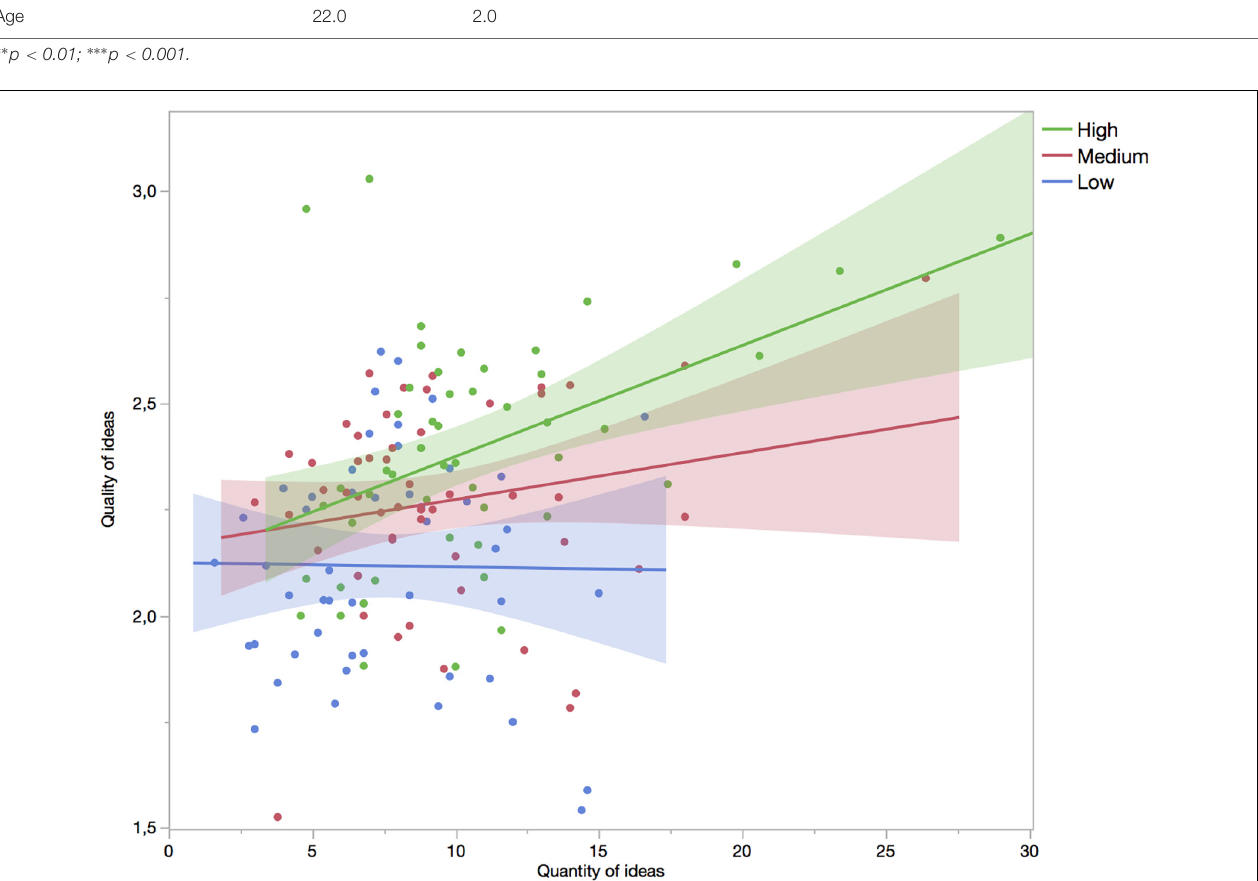
FIGURE 1 | The correlation between the quantity of ideas produced and the rated quality of each idea, which for visualization purposes is calculated separately for each of three levels of openness to experience (high, medium, and low). The color bands each represent the 95% confidence region for the fitted line.